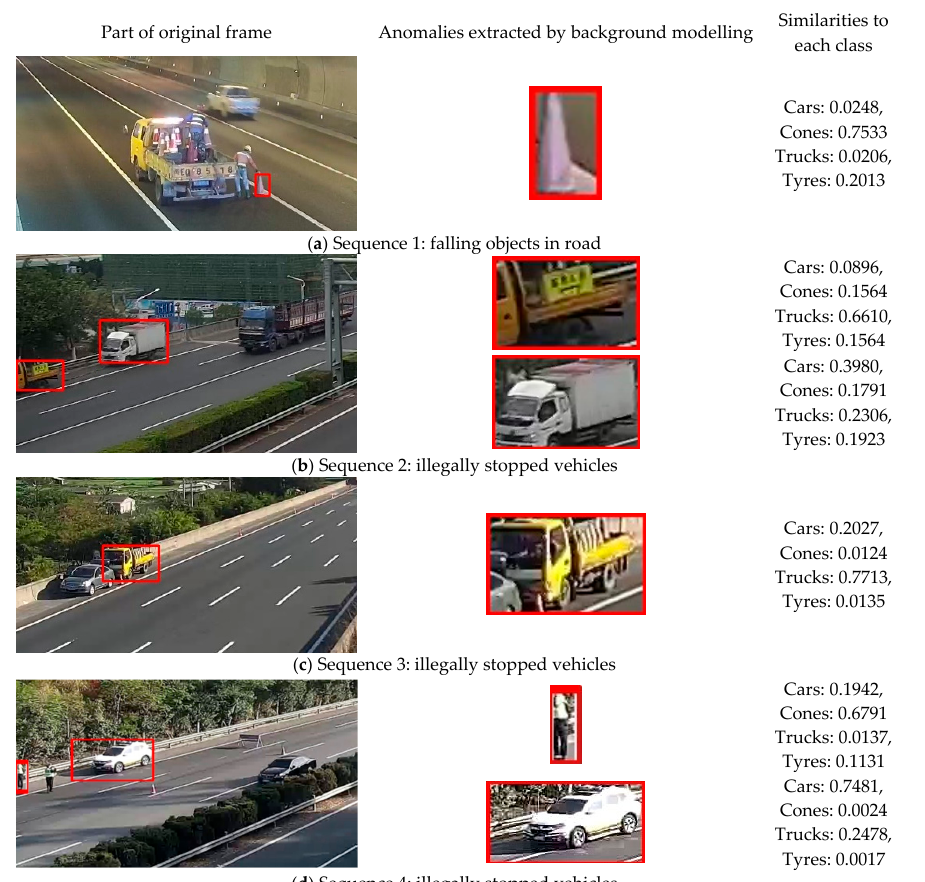
Figure 10. Road anomaly detected by background modeling: ( a ) Sequence 1: falling objects in road; ( b ) Sequence 2: illegally stopped vehicles; ( c ) Sequence 3: illegally stopped vehicles; ( d ) Sequence 4: illegally stopped vehicles. The first column shows the Region of Interests (ROIs) from original frame. The image blocks in the middle column shows the anomalies extracted by the background modeling method. The values in the last column indicate the similarities between each image block and each